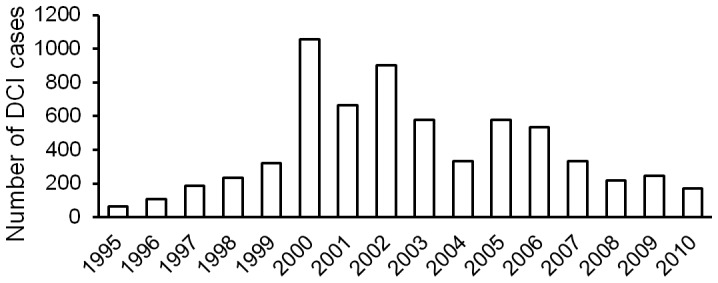
The number of DCI cases treated in two hyperbaric facilities from 1995 to 2010.The cases in 1995–1999 and a portion of the cases in 2000 were from another hyperbaric facility [9], the other portion of the cases in 2000 and the cases in 2001–2010 were treated at our facility. These two facilities received approximately 80% of DCI cases in the region during the period.